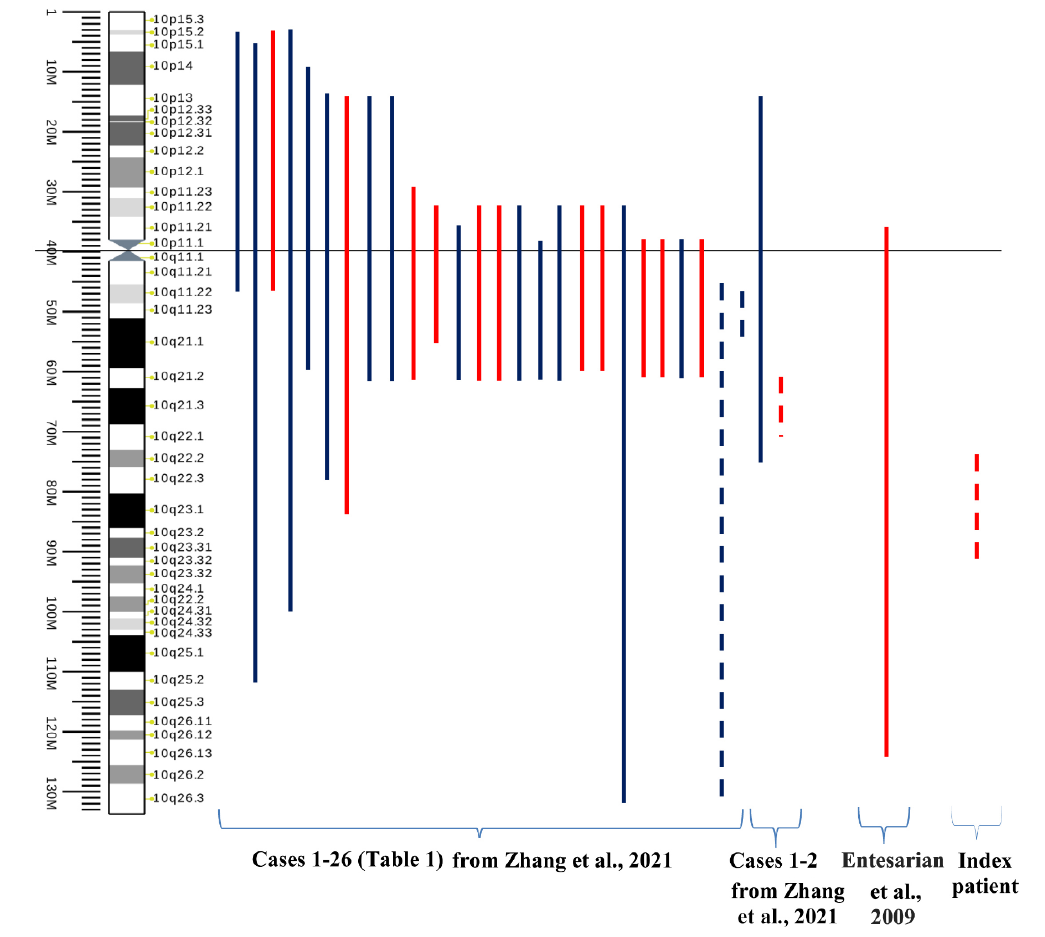
Figure 13. The map of chromosome 10 inversions in men. Red lines denote inversions detected in males with infertility, azoospermia, oligozoospermia, or recurrent miscarriage in the wife. Blue lines denote normal phenotype or cases with unavailble clinical data. Only four cases of paracentric inversion of 10q have been reported, including our case (dotted lines). (The source of the ideogram: https://commons.wikimedia.org/wiki/File:Human_chromosome_10_ideogram_vertical.svg accessed on 5 November 2022). “Cases 1–26” are reviewed cases in Table 1 from [39], “Cases 1–2” are own clinical observations from [39], and “[40]” – a case of pericentric inversion from [40].